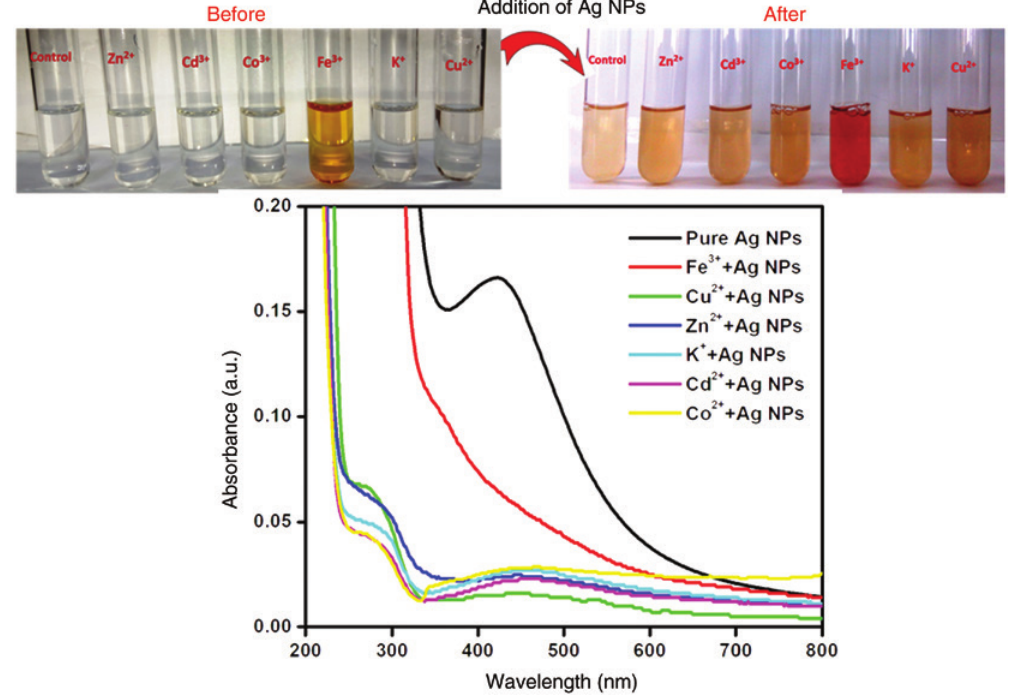
Figure 9: Visual and spectroscopic sensing of different metal ions by silver nanoparticles